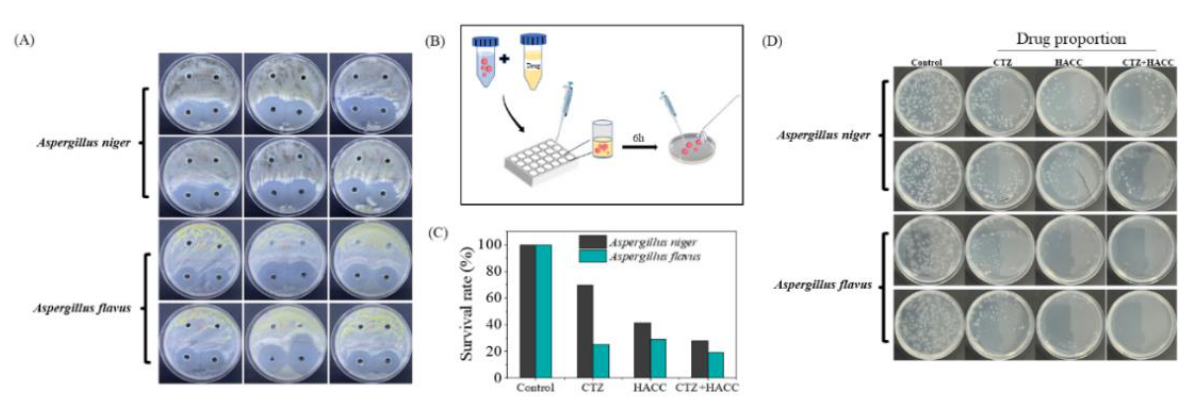
Figure 7. The bactericidal effect of three sets of microemulsions on mold. ( A ) Inhibition zone of microemulsion formulations on 2 kinds of molds; ( B ) the process of the bacteriostasis experiment; ( C ) the survival rate of mold; ( D ) the synergy of CH.